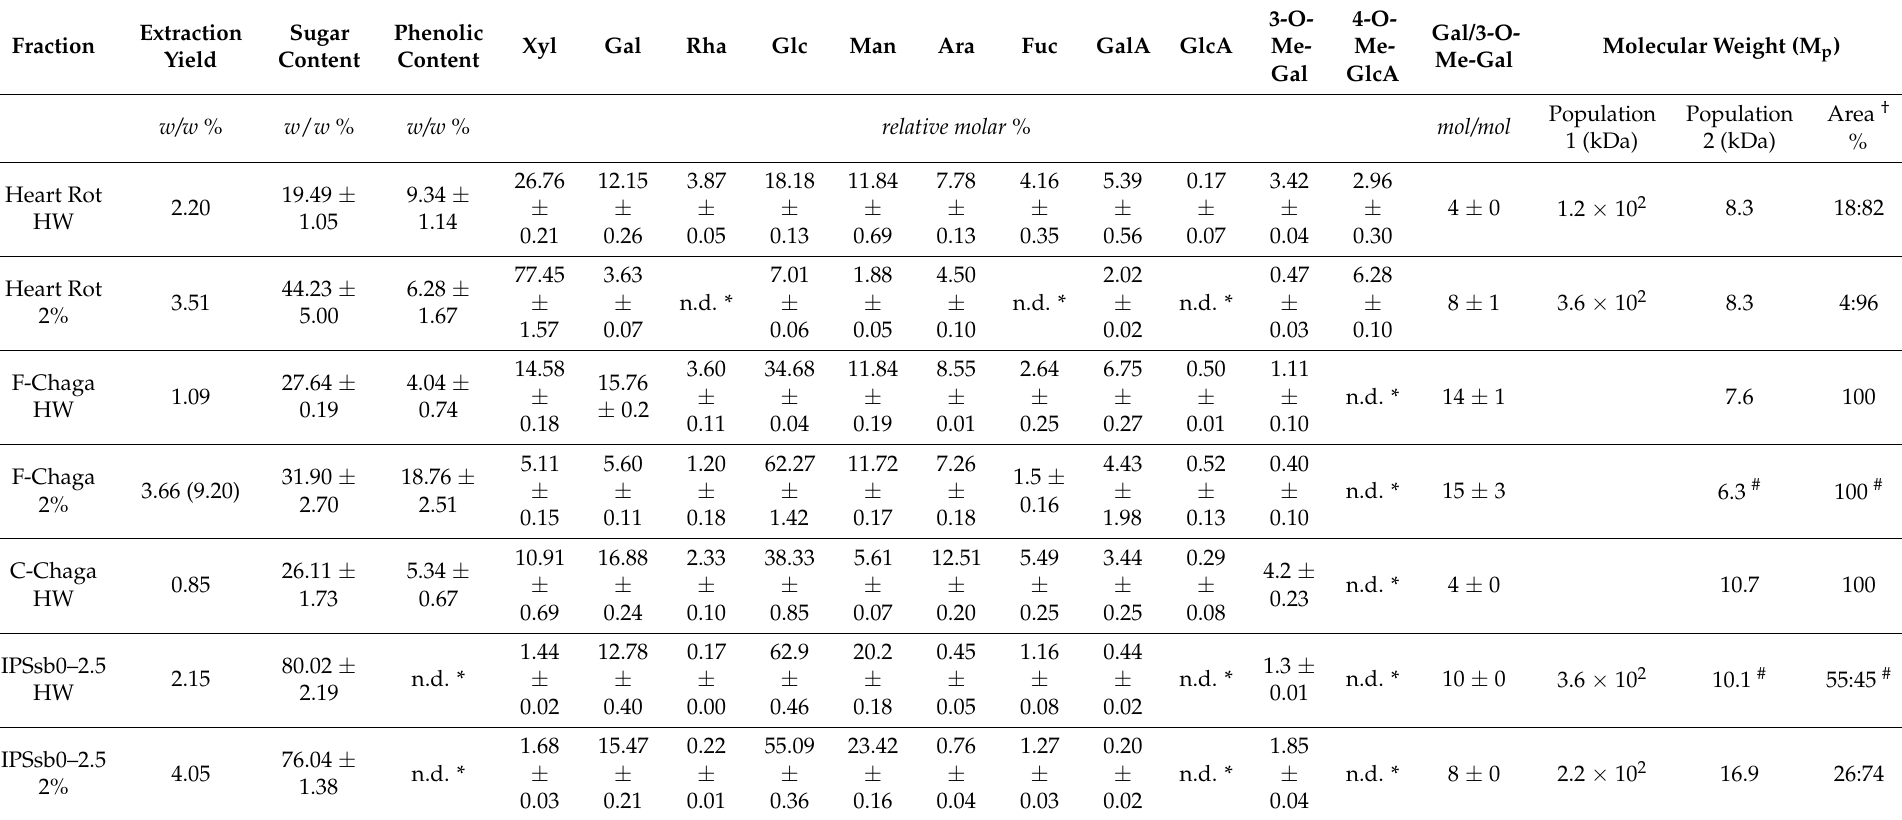
Table 1. Extraction yield, sugar, and phenolic contents; monomer composition and molecular weight (M p ) of the polysaccharide fractions produced from heart rot, sterile conk, and cultivated mycelium.